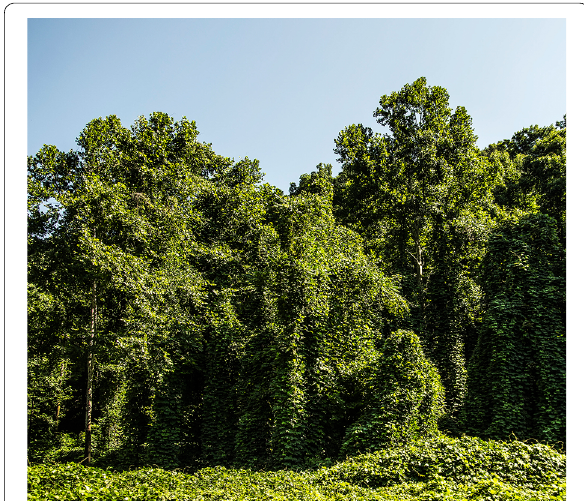
Fig. 7 Kudzu ( Pueraria montana ) is a weed that covers with a thick layer the existing vegetation killing everything that is underneath.